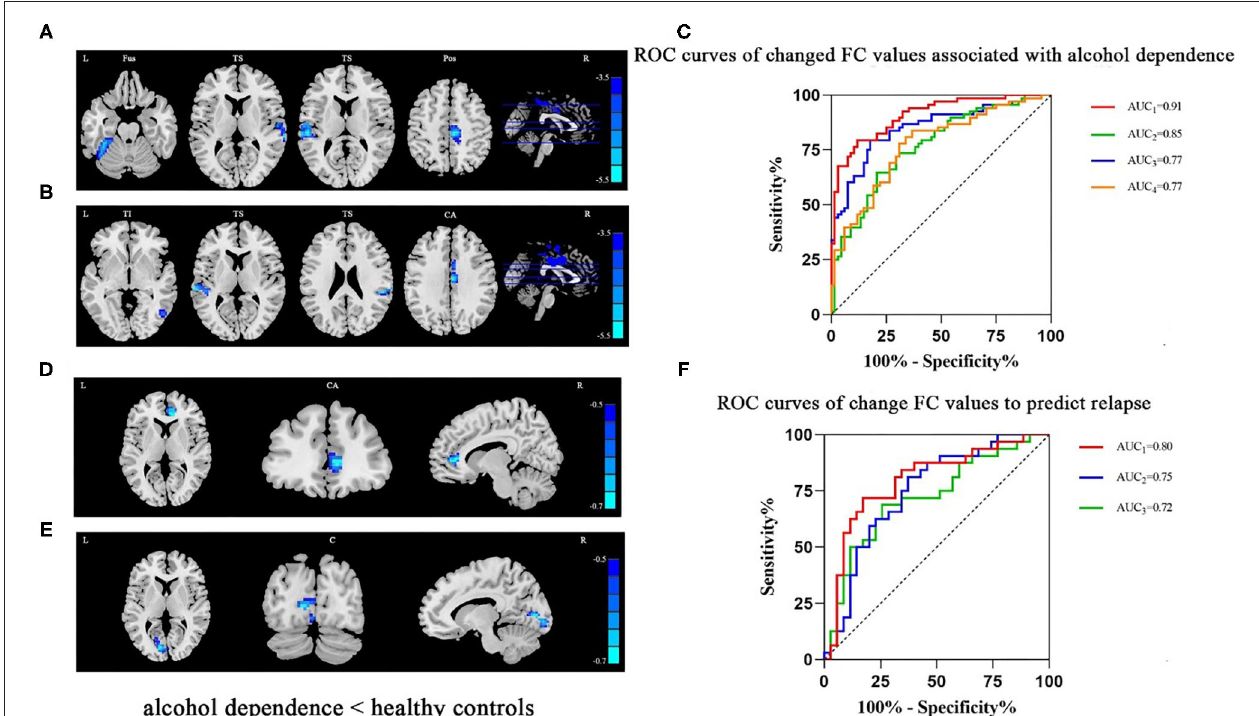
FIGURE 1 | (A) In patients with AD, lower FC was detected in the left fusiform, bilateral temporal superior and right postcentral areas (seed: NAc). (B) In patients with AD, lower FC was detected in the right temporal inferior, bilateral temporal superior and left cingulum anterior areas (seed: mPFC). (C) The ROC curves of logistic regression models using all three indicators (smoking status and two FC indicators, AUC 1 = 0.91) or two FC indicators (AUC 2 = 0.85), only FC between the NAc and left fusiform (AUC 3 = 0.77), or only FC between the mPFC and left cingulum anterior (AUC 3 = 0.77) to differentiate AD cases and HCs. (D) Among patients with AD who had relapsed based on the follow-up survey, lower FC in the right cingulum anterior (seed: NAc) was detected. (E) Among patients with AD who had relapsed, lower FC in the left calcarine (seed: mPFC) was detected. (F) The ROC curves of logistic regression models using both FCs (AUC 1 = 0.80), only FC between NAc and right cingulum anterior (AUC 2 = 0.75), or only FC between mPFC and left calcarine sulcus (AUC 3 = 0.72) to predict relapse. Clusters were labeled with the Automated Anatomical Labeling (AAL) atlas. The t maps of (A,B) were drawn with a threshold of p < 0.001 at the voxel level and P FWE < 0.05 at the cluster level. Though the results of (D,E) could not exist relative to the above threshold, t maps of these results were shown with a threshold of p < 0.016 at the voxel level and P FWE < 0.05 at cluster level. The color bar indicates voxel-wise t values. lower FC is shown in blue. The brighter the blue, the lower the FC. FC, functional connectivity; NAc, nucleus accumbens; mPFC, medial prefrontal cortex; L, left; R, right; Fus, fusiform; TS, temporal superior gyrus; Pos, postcentral; TI, temporal inferior; CA, cingulum anterior; C, calcarine sulcus; ROC, receiver operating characteristic; AUC, area under curve; AD, alcohol dependence.